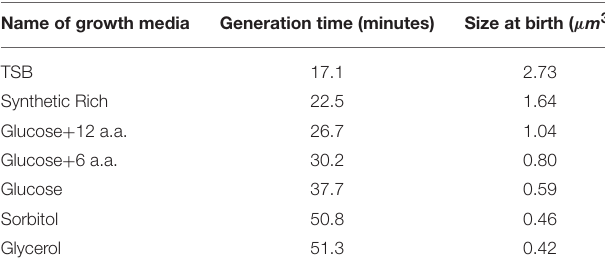
TABLE 1 | Name of the growth conditions, average generation time, and average cell size at